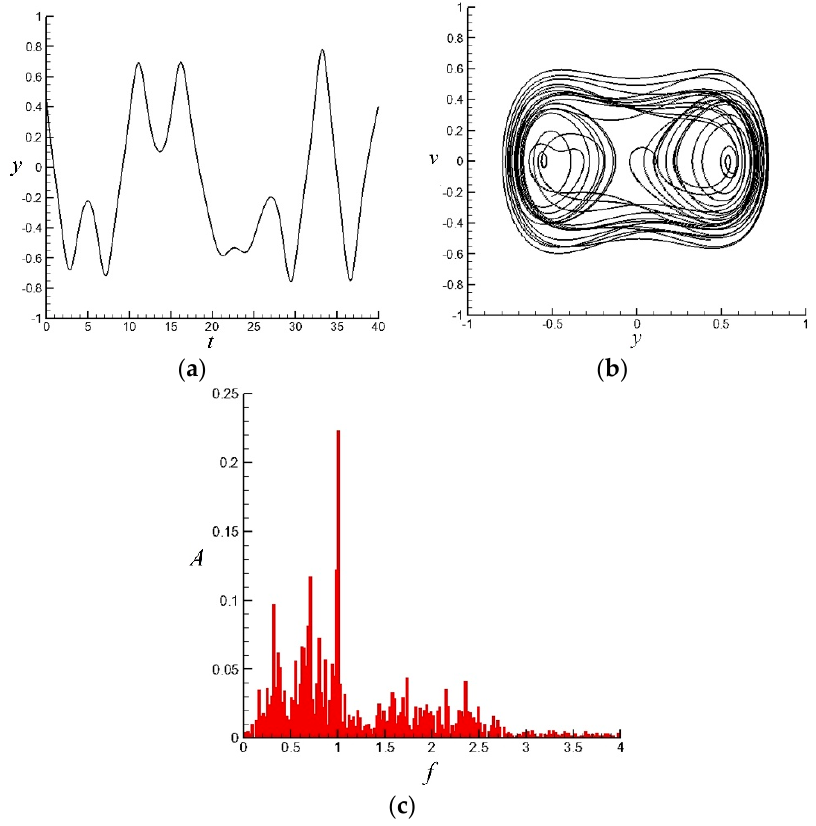
Figure 4. Response of the model without control (all variables are nondimensional): ( a ) Time–displacement ( y − t ) diagram; ( b ) Velocity–displacement phase ( v − y ) diagram; ( c ) FFT of displacement ( A − f